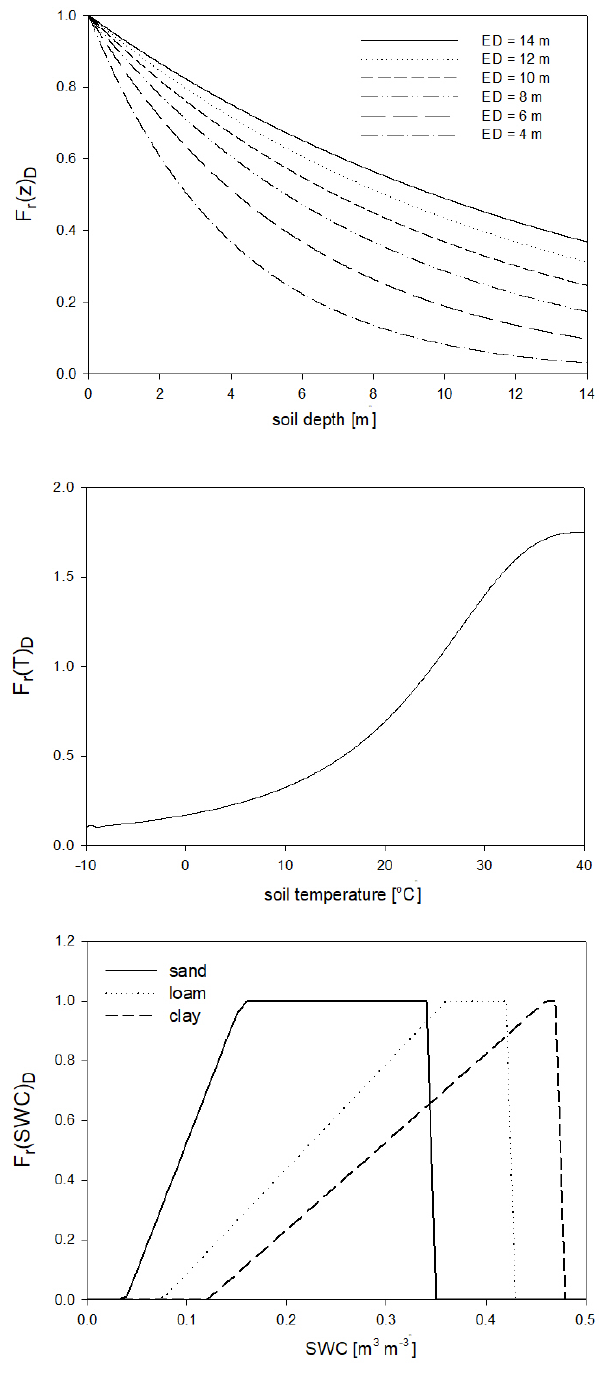
Figure 5. The dependence of the individual factors that form the complex environmental response function of decomposition on depth ( F r (d) D ), temperature ( F r (T ) D ), and SWC in the case of dif- ferent soil types ( F r ( SWC ) D ). ED is the e -folding depth, which is one of the adjustable soil parameters of the model. For the definition of sand, silt, and clay see Fig.